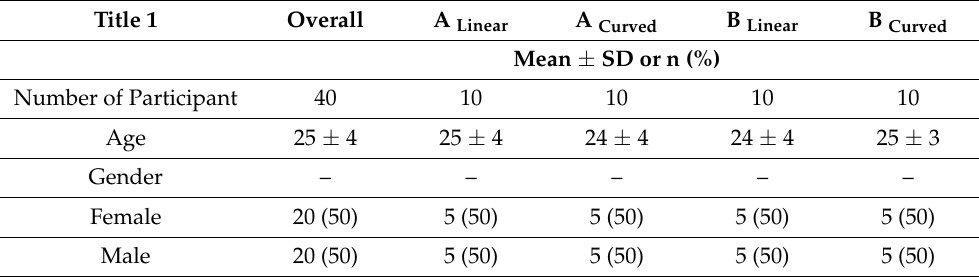
Table 1. Participant personal